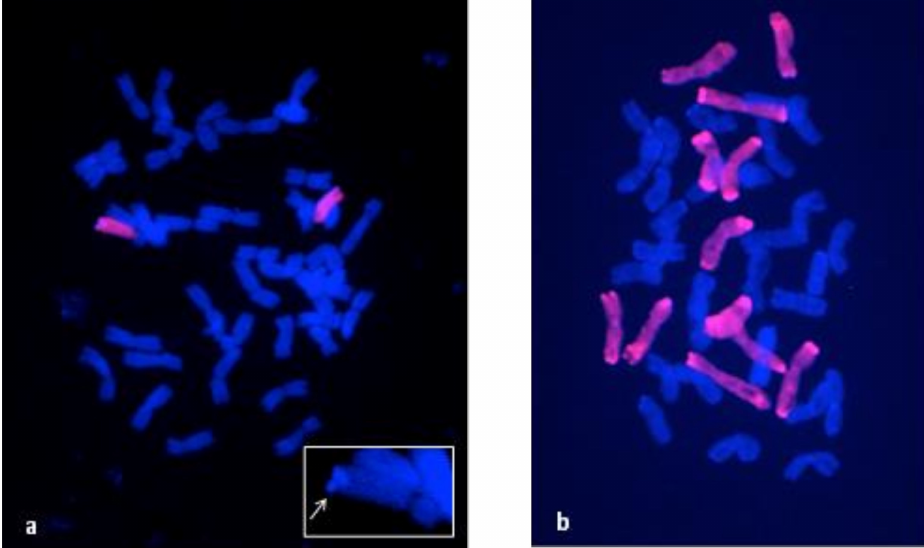
Figure 2. Genomic in situ hybridization (GISH) with total ryeCy3 labeled DNA as probe (red) on N11 XY7 ( a ) and XY7 ( b ) metaphase spreads. DNA is counterstained with DAPI. Rye chromosomes or chromosome arms are red. In the box a telomeric DAPI band present in the rye chromosome arm is highlighted by a white